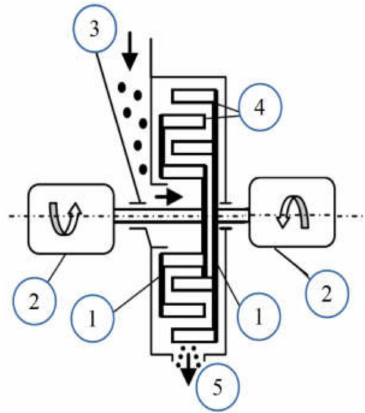
Figure 7. Impact disintegrator DSL-175 (Tallinn University of Technology (TalTech)). 1, rotors; 2, electric drivers; 3, inlet for raw material; 4, grinding elements (pins, blades); 5, outlet for processed (milled)